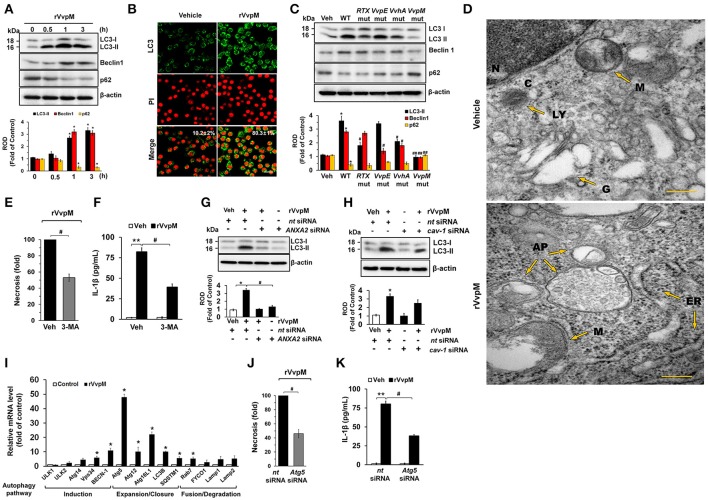
VvpM induces autophagy by regulating non-lipid raft ANXA2. (A) The effect of rVvpM on expressions of autophagy-related proteins, LC3, Beclin-1, and p62 were determined by Western blot. Data represent the mean ± S.E. n = 4. (B) LC3 expression (green) in cells treated with rVvpM for 3 h was visualized by confocal microscopy and quantified by using Image J program, which measures the stained area per microscopic filed with consistent threshold. Scale bars, 100 μm. n = 4. (C) The expressions of autophagy-related proteins in a cells infected with WT or various mutant deficients for 1 h are shown. n = 4. *P < 0.05 vs. Veh (boiled WT). #P < 0.05 and ##P < 0.01 vs. WT, respectively. (D) Formation of autophagic vesicles in cells treated with rVvpM for 3 h was visualized by transmission electron microscopy. Scale bars, 100 nm. n = 3. AP, autophagosome; C, cytosol; ER, endoplasmic reticulum; N, nucleus; G, golgi body; M, mitochondria. (E) Cells were pre-treated with 3-MA (10 mM) for 30 min prior to rVvpM exposure for 24 h. FACS analysis and quantitative analysis of the percentage of necrotic (Q1) cells are shown. n = 4. (F) The level of IL-1β protein was quantified by ELISA. n = 5. LC3 expression in cells transfected with siRNAs for ANXA2
(G) and cav-1
(H) for 24 h prior to rVvpM exposure for 3 h. (I) The effect of rVvpM on the expression of autophagy-related proteins was evaluated by qRT-PCR. The expression level of Atg5 and Atg16L1 was markedly increased by rVvpM treatment. n = 4. (J) Cells transfected with Atg5 siRNA were incubated with rVvpM for 24 h. FACS analysis and quantitative analysis of the percentage of necrotic (Q1) cells are shown. n = 4. (K) The level of IL-1β protein was quantified by ELISA. n = 5. (A,I)
*P < 0.01 vs. cells with no treatment. (E,F)
**P < 0.01 vs. Veh (boiled rVvpM). #P < 0.05 vs. Veh + rVvpM. (G,H,J,K)
*P < 0.05 and **P < 0.01 vs. nt siRNA + Veh (boiled rVvpM), respectively. #P < 0.05 and ##P < 0.01 vs. nt siRNA + rVvpM, respectively. ROD, relative optical density.